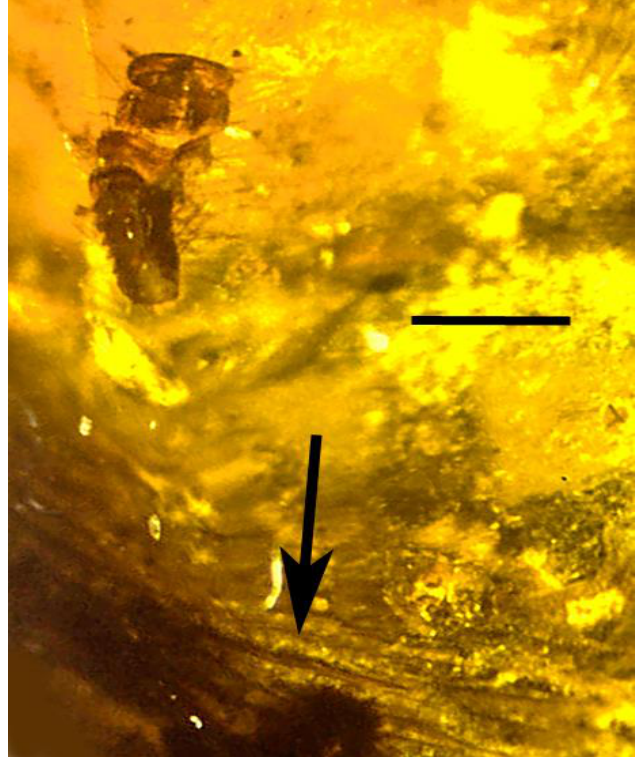
Figure 29. Larva of dermestid beetle (Coleoptera: Dermestidae) adjacent to bird remains (arrow) in Burmese amber. Scale bar = 1.5 mm.